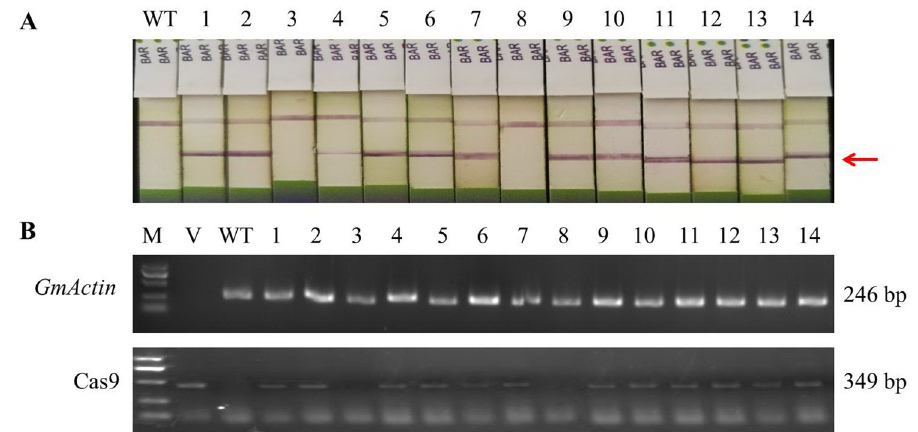
Fig 5. The partial result of identifying tcp19l mutants without the BAR and Cas9 sequences of the CRISPR/Cas9 vector. (A) Detection of the selectable marker BAR by test strip. WT, wild type soybean plant. Labels 1–14, individual mutant plants. The bands at red arrowhead indicate that BAR is positive. (B) Gel images of PCR products obtained with a set of primer pairs for the Cas9 of sgRNA/Cas9 vectors. Cas9 (349 bp), part of the Cas9 coding sequence. GmActin (Glyma.18G290800.1) was used as a normalization control. M, DL2000 DNA marker. V, plasmid of CRISPR/ Cas9 vector used in transformation. WT, DNA of wild type soybean plant. Labels 1–14, individual mutant plants.